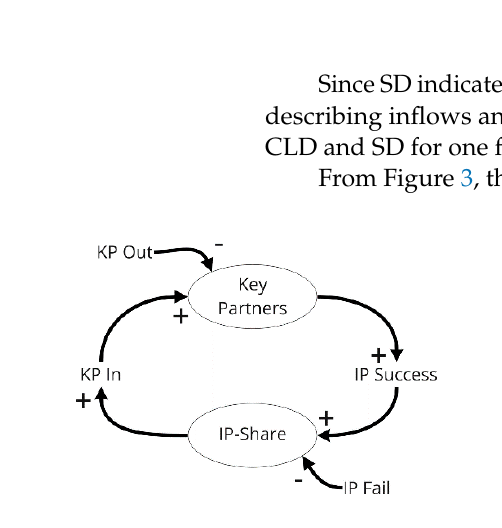
Figure 3. Simple CLD and SD for Key Partners and IP Share.